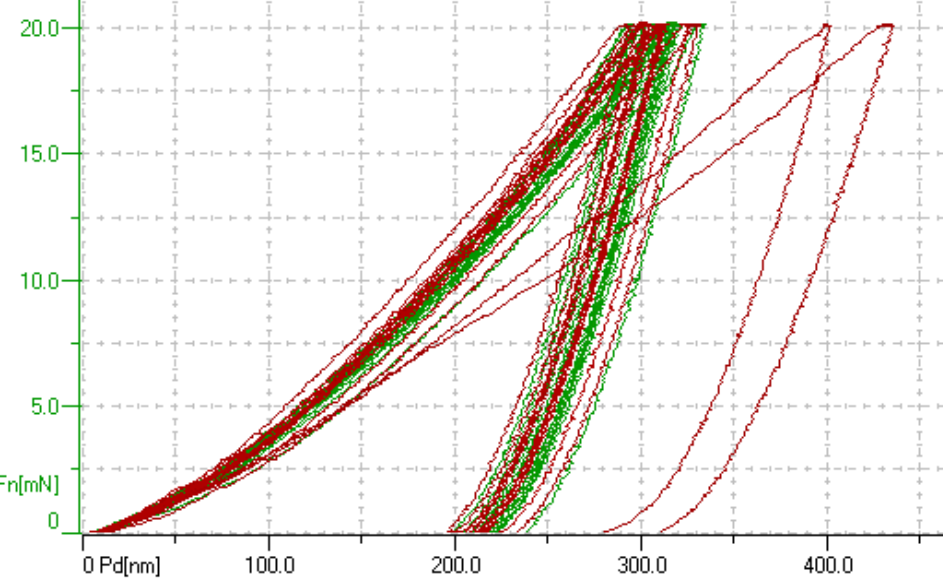
Figure 4. The experimental indentation curves of the single-phase alloy NiAl–Cr–Co+2.5%Mo and the double-phase alloy NiAl–Cr–Co+0.5%Zr.